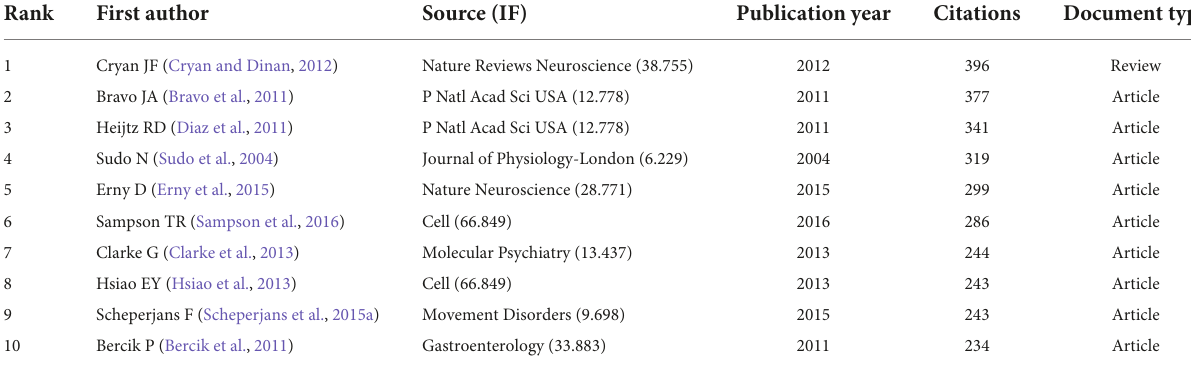
TABLE 6 Top 10 highly co-cited references on research in gastrointestinal microbiome and